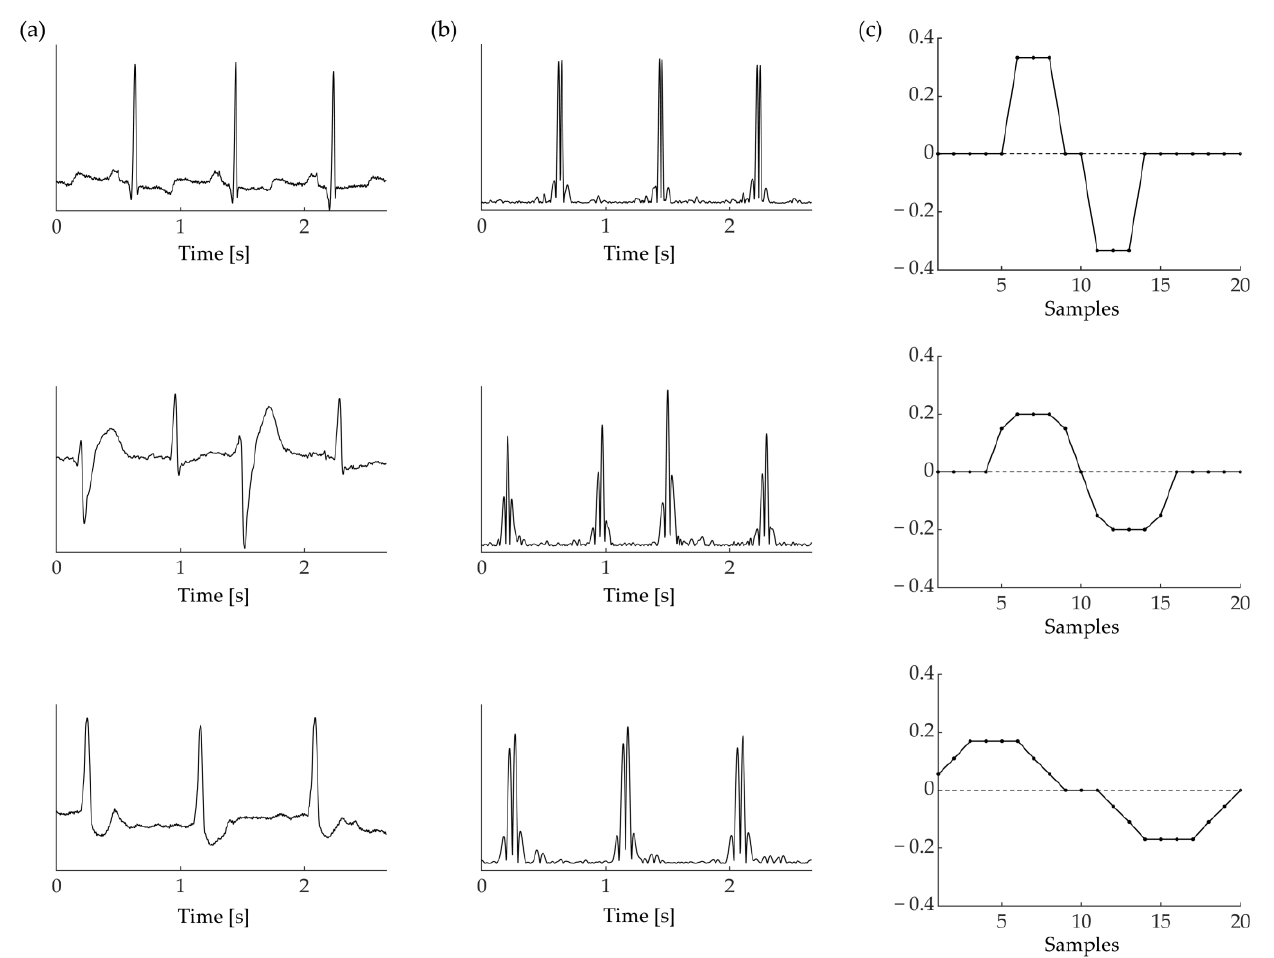
Figure 5. ( a ) Three ECG excerpts from the MIT-BIH database. From top to bottom: record 100, 200, 203. ( b ) Absolute derivative resulting from the application of three distinct dMACs, portrayed in ( c ). The dMAC used for each record is chosen with SQI maximization (Equation (1)).